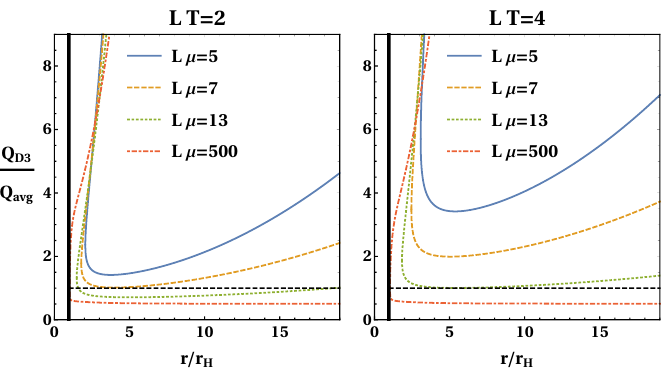
Figure 7 . The curves show the angular momentum where the e(cid:11)ective potential crosses zero as a function of radius, for backgrounds with k = 1 and all charges